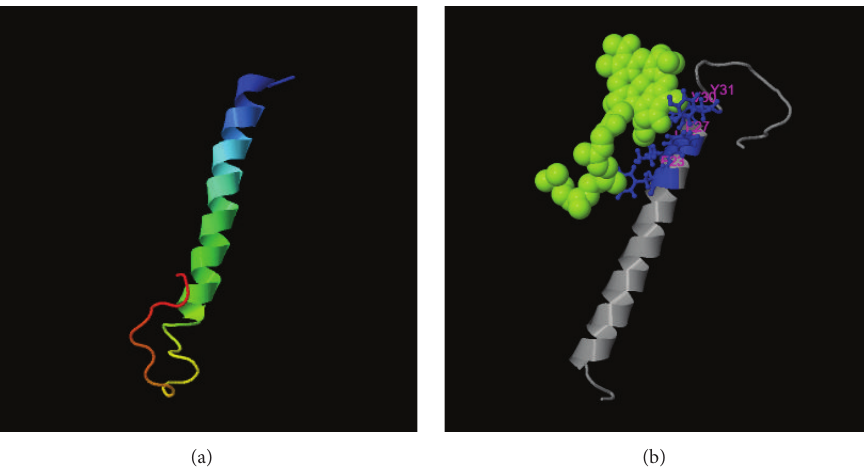
Figure 5: Predicted protein structure for the complete transforming transmembrane protein E5 generated using the I-TASSER server. (a) The predicted E5 protein structure created by the program. (b) A predicted ligand-binding site on E5, this site is a possible location for E5/PDGF 𝛽 - R